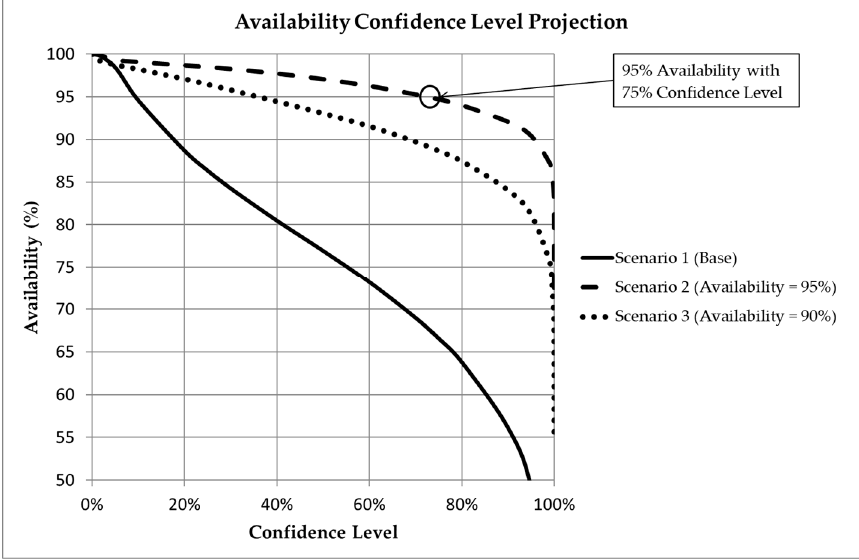
Figure 5. Availability confidence level of the PSS with optimized field kit in place.